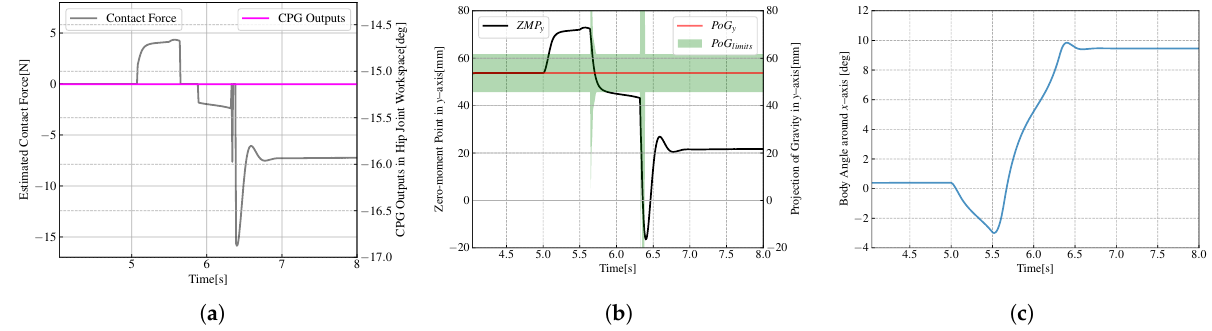
Figure 9. Variations of variables when the robots standing on a single foot without CPG. ( a ) Variations of contact force and CPG output. ( b ) Variations of ZMP, the estimated projection of gravity (PoG) and the limit of PoG. ( c ) Variations of body angle.